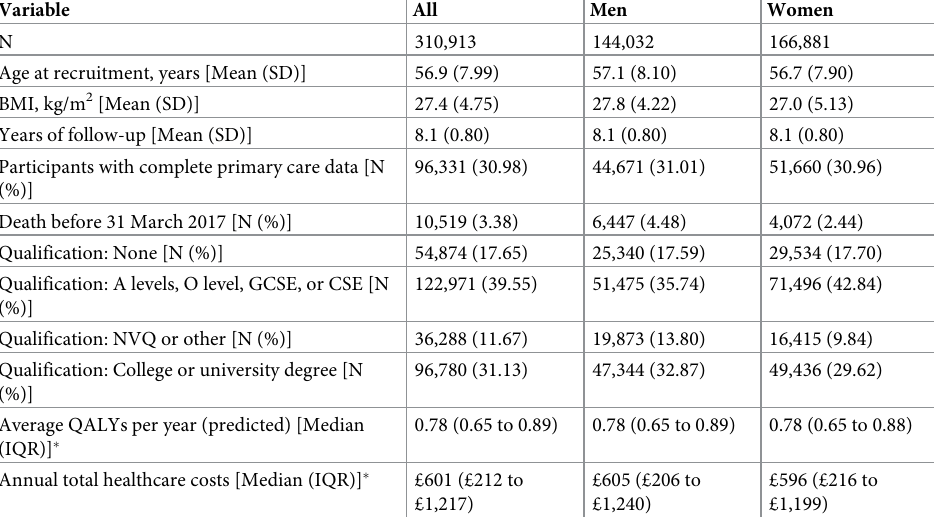
Table 2. AU : DuetochangeinlabelfromBox 1 toTable 1 ; Tables 1 and 2 andtheirrespectivecitationshavebeenchangedtoTables 2 and 3 ; respectively : Summary demographics of UK